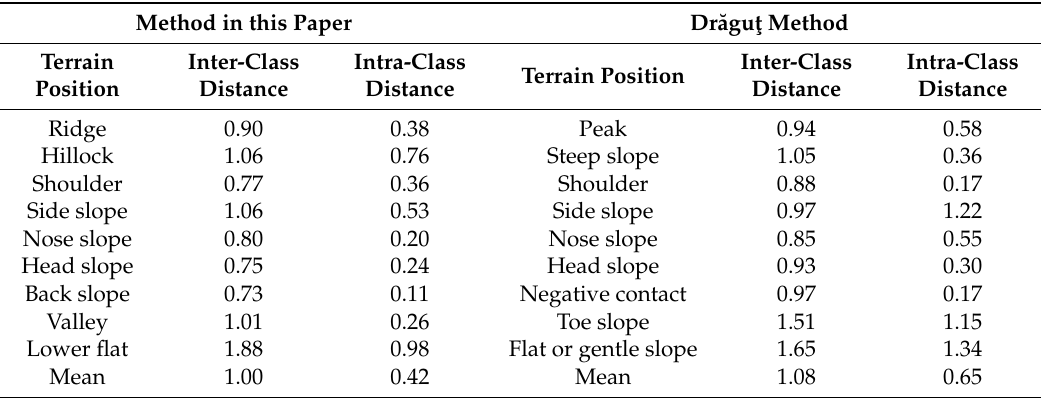
Table 4. Distances of intra- and inter-class for terrain positions.